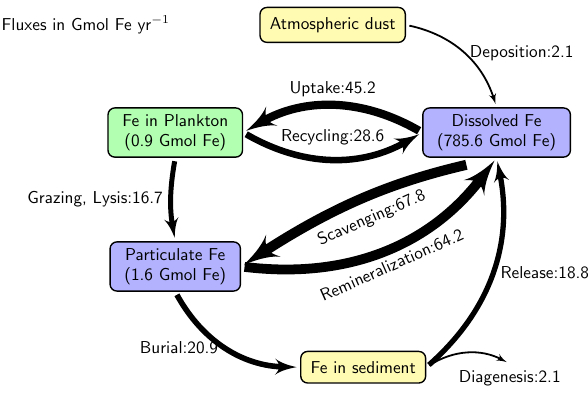
Figure 3. Global annually averaged iron fluxes as simulated with the dynamic iron cycle in the UVic model in GmolFeyr − 1 . Arrow thickness is scaled with the size of the fluxes. The numbers inside the boxes denote the globally integrated amounts of iron in the re- spective pools in Gmol